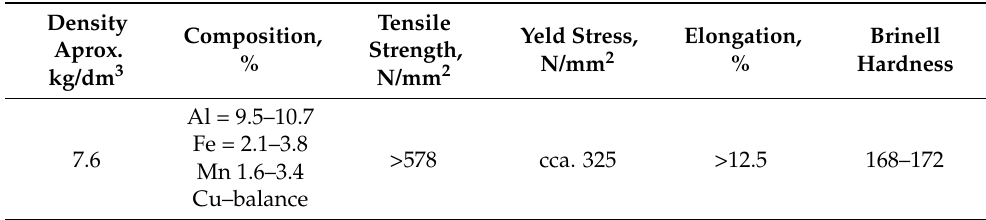
Table 1. The chemical composition and mechanical properties of aluminum bronze (C62300).